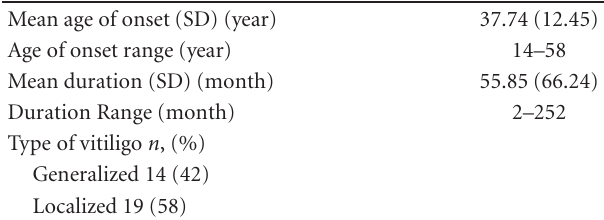
Table 2: Clinical characteristics of patients with vitiligo. Mean age of onset (SD)